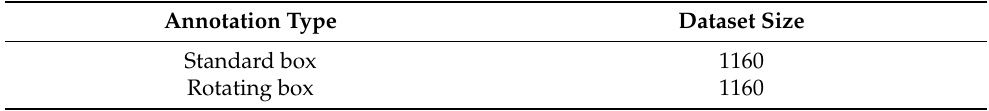
Table 1. Original annotated dataset